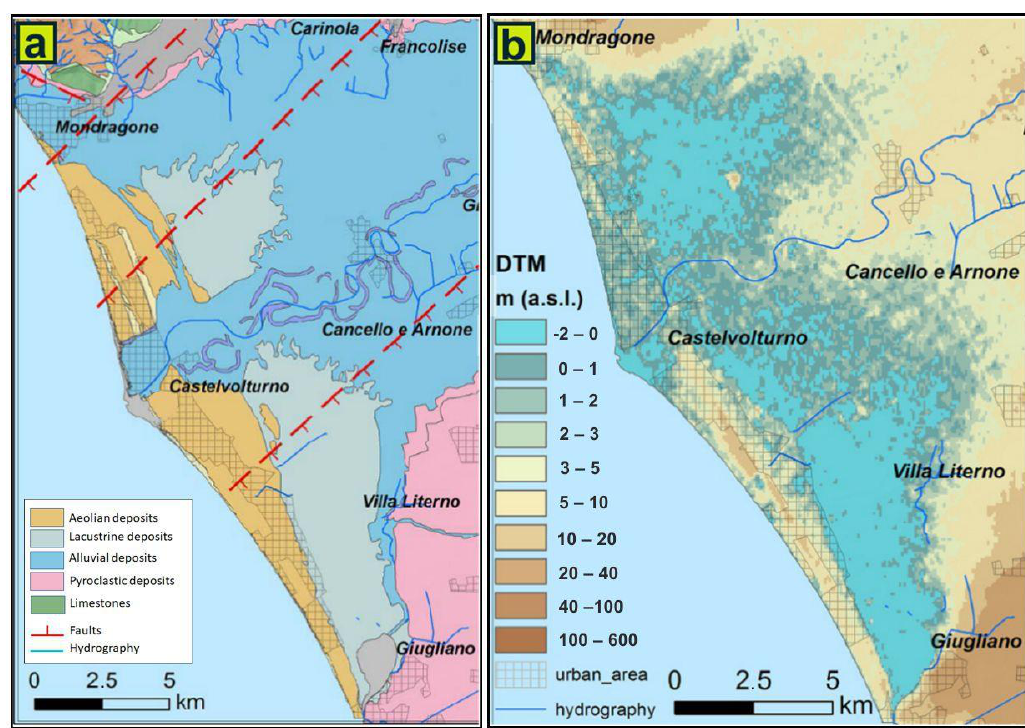
Figure 3. Schematic geologic map of the Volturno River delta plain ( a ) and digital terrain model of the same area ( b ), slightly modified from Matano et al. [9].